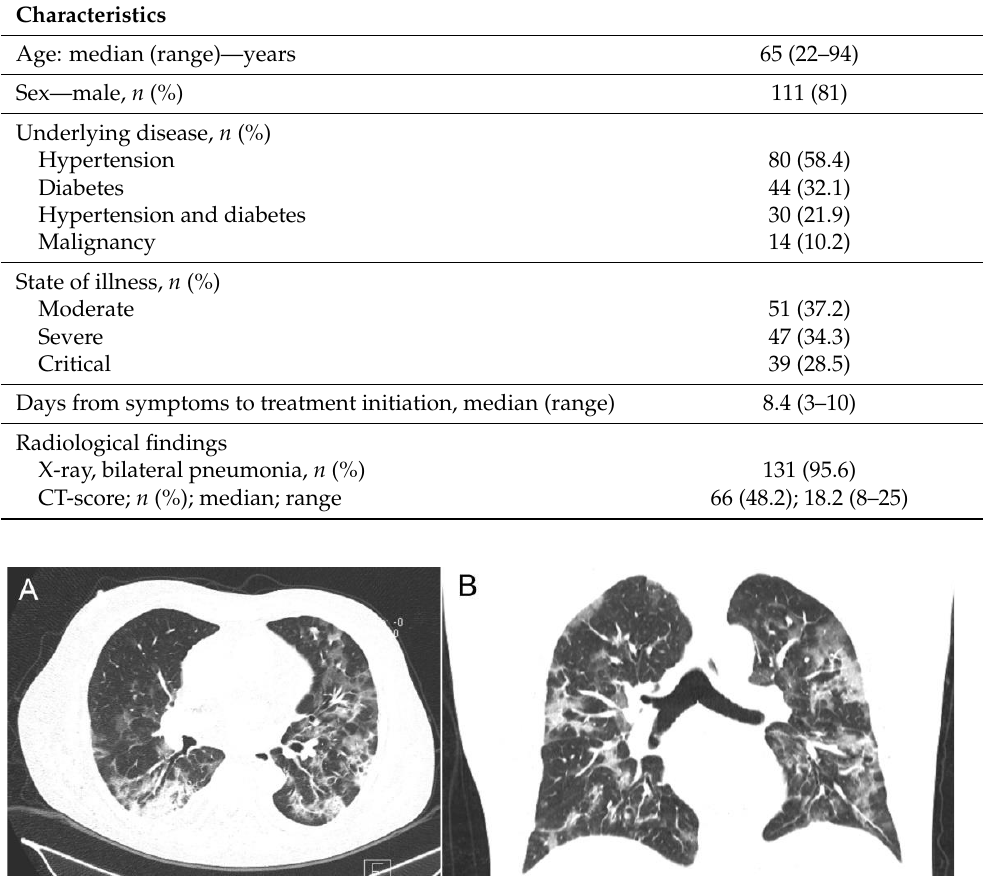
Figure 1. A male patient in early 50 s, categorized as a moderately ill COVID-19 patient, presenting symptoms for 13 days; chest CT scan shows multilobar, diffuse consolidation and ground glass opacification; some features of organizing pneumonia (CT score = 18). ( A ) axiale slice. ( B ) coronal slice.